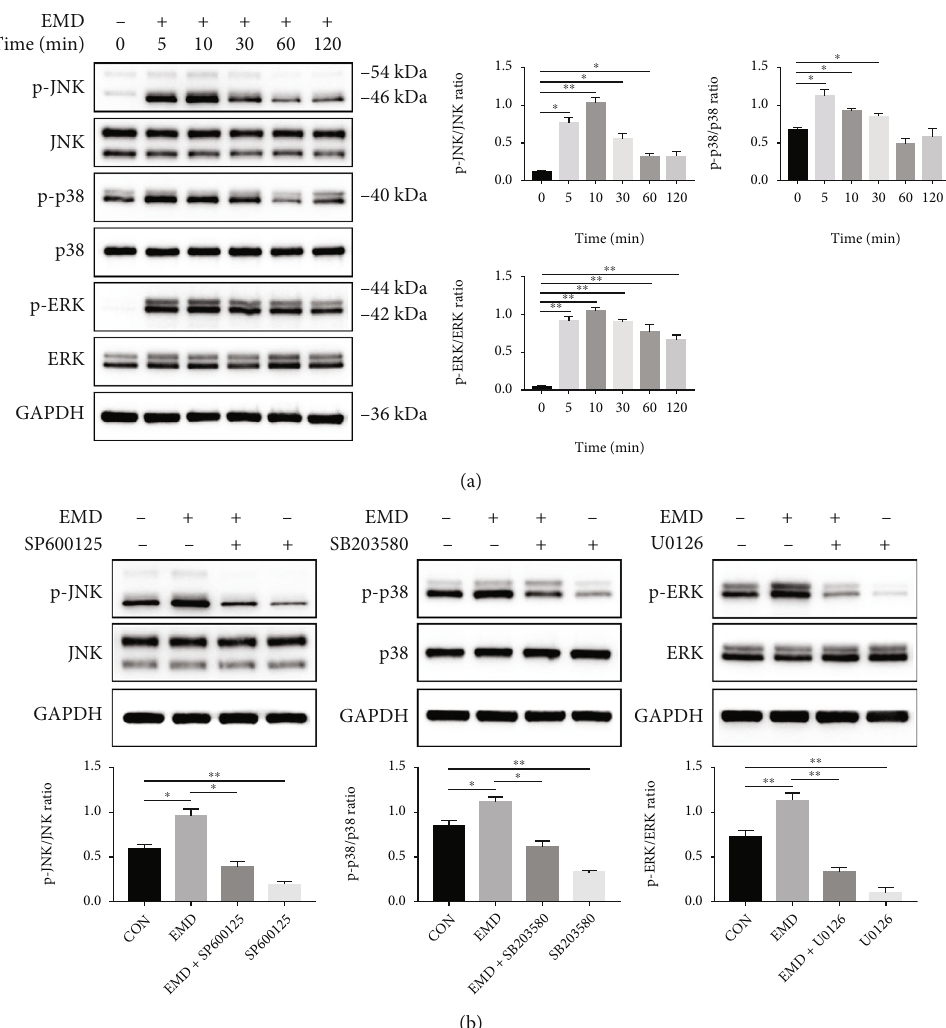
Figure 6: EMD activated the MAPK signaling pathways in DPSCs. (a) Protein expression levels of JNK, p-JNK, p38 MAPK, p-p38 MAPK, ERK1/2, and p-ERK1/2 in EMD-treated DPSCs were detected by western blot analysis at di ff erent time points (0, 5, 10, 30, 60, and 120min). (b) DPSCs were pretreated with speci fi c pathway inhibitors (SP600125 targeting JNK, SB203580 targeting p38 MAPK, and U0126 targeting ERK) for 1h and then stimulated with EMD. SP600125 and U0126 group were stimulated for 10min, and SB203580 group was stimulated for 5min. The e ff ectiveness of the inhibitors was veri fi ed by western blot assay. Quanti fi cation was done by Image Lab ™ software. The results are presented as means ± SD of three independent experiments ( n =3). ∗ P < 0 : 05 , ∗∗ P < 0 : 01